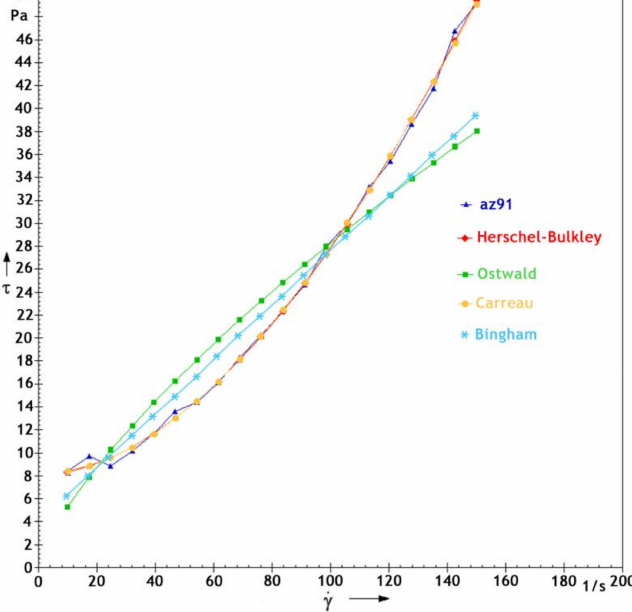
Figure 5. Flow curves for alloy AZ91: actual and computed from the Hershel-Bulkley ( R 2 = 0.99873), Ostwald ( R 2 = 0.87918), Carreau ( R 2 = 0.99875), and Bingham ( R 2 = 0.91265)